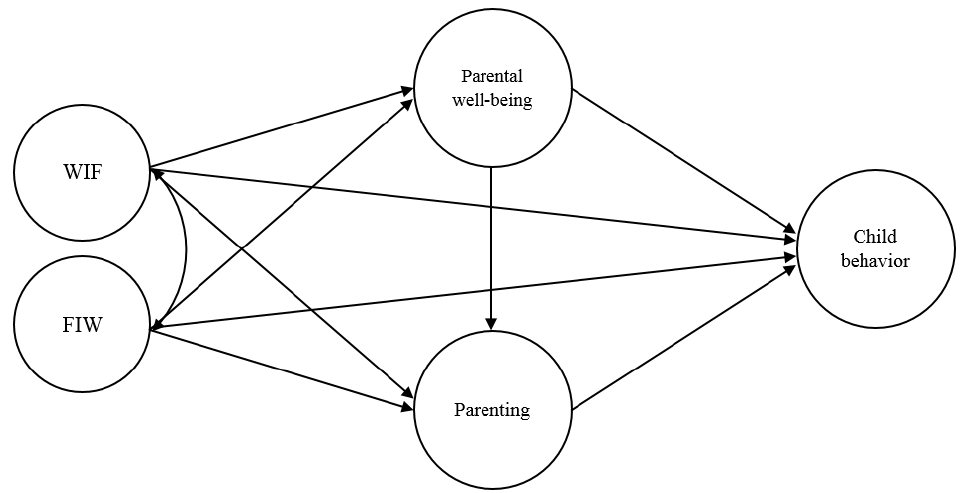
Figure 1 : Path diagram of the conceptual